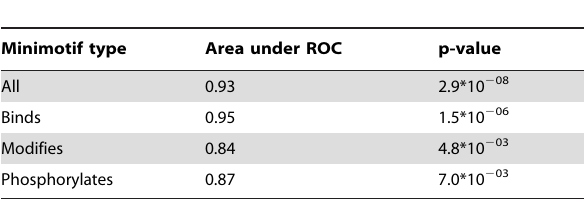
Table 4. ROC curve statistics for differ types of minimotifs.